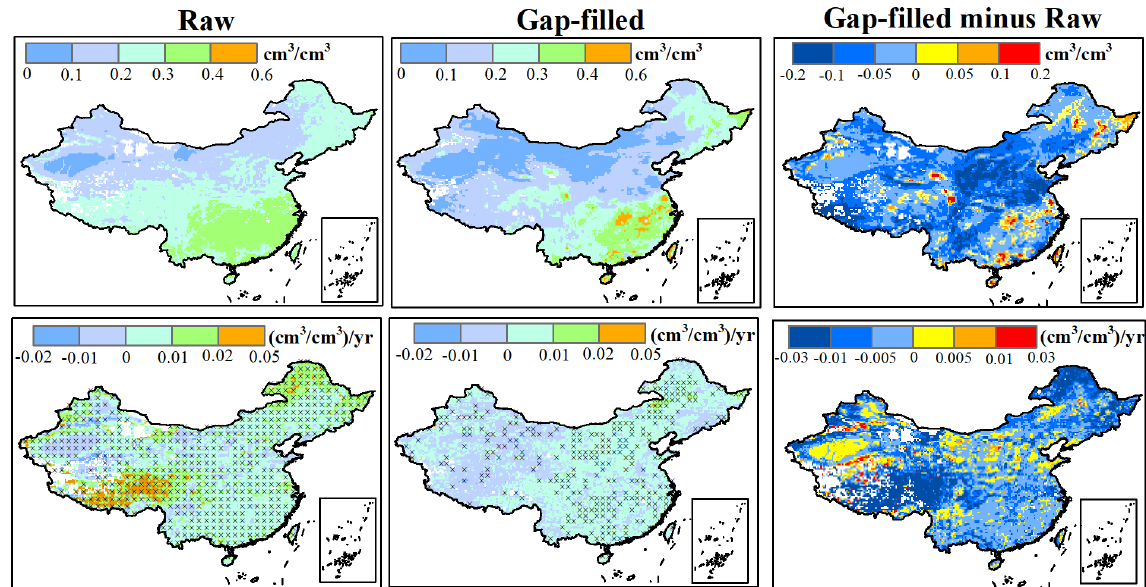
Figure 13. Implementation of the proposed model in 2005–2015. Panels (a) and (b) are the average values of raw CCI and gap-filled SM during 2005–2015, and panel (c) is the difference between them. Panels (d) and (e) are the average trends of raw CCI and gap-filled SM during 2005–2015, and panel (f) is the difference between them. The “x” symbol in panels (d) and (e) denotes the significance level under